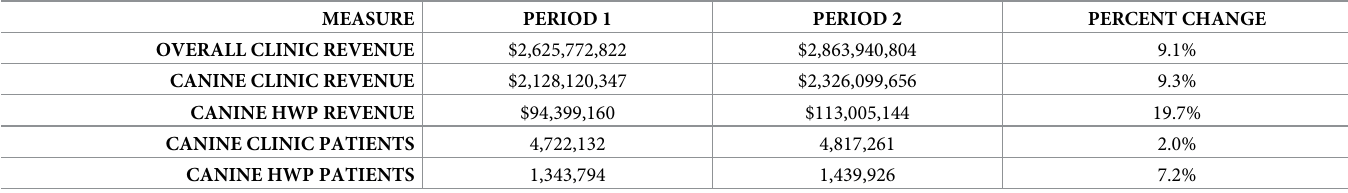
Table 5. All practice revenue comparison Period 1 vs Period 2. PH 6 to PH 12 Users.